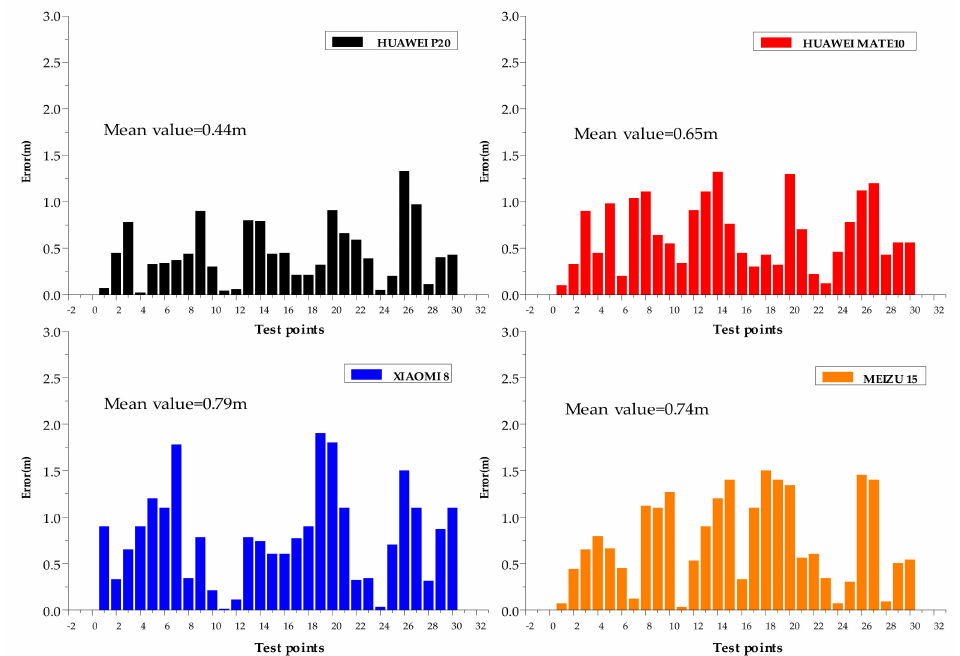
Figure 18. Adaptability of positioning model at di ff erent